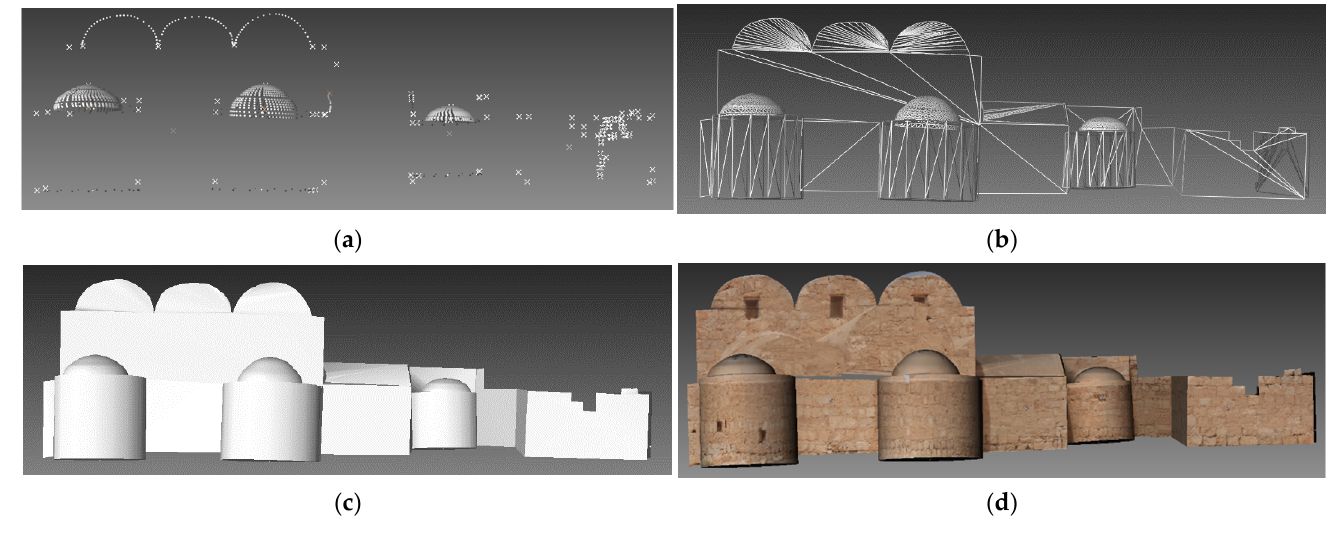
Figure 14. Part of the 3D Model for Qaser Amra using PhotoModeler (south side): ( a ) Point cloud model; ( b ) Wire frame model; ( c ) Render model; ( d ) Textured model.